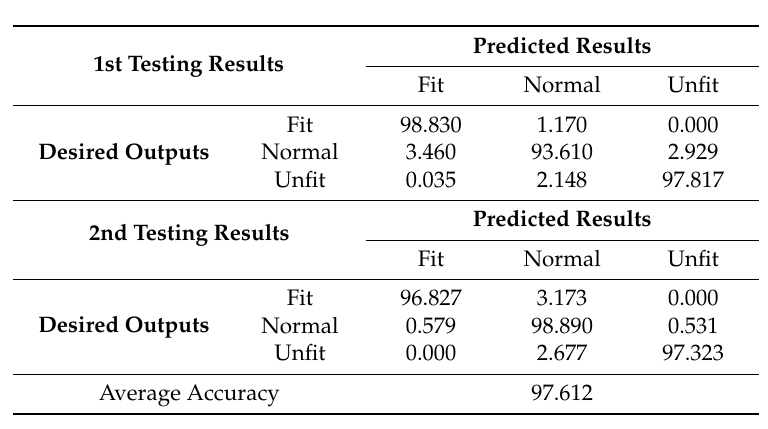
Table 5. Confusion matrices of the testing results on the INR banknote fitness dataset using the proposed